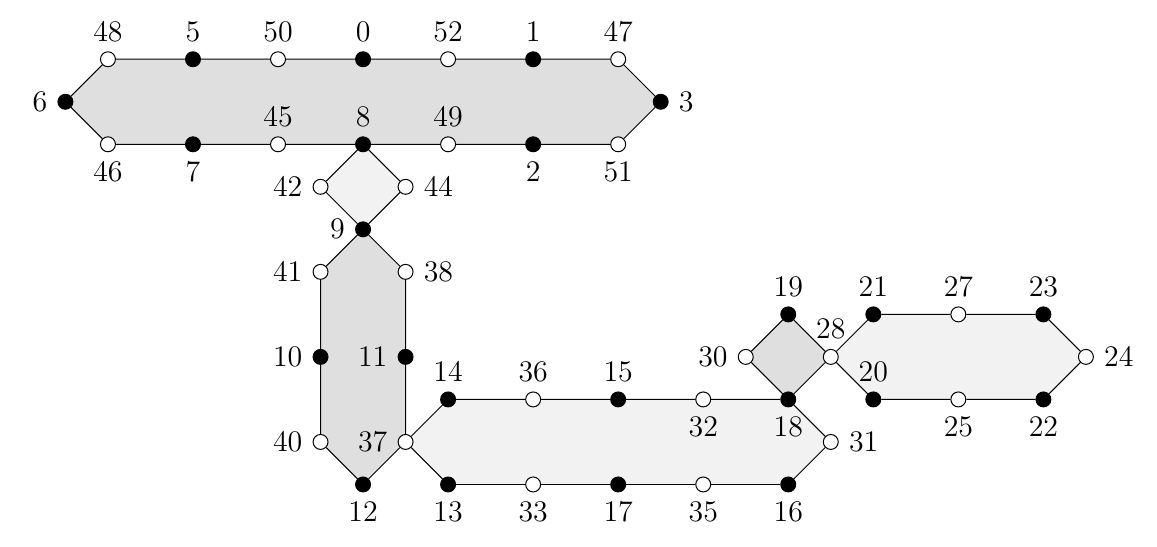
Figure 3: An α -labeling of a blended cyclic